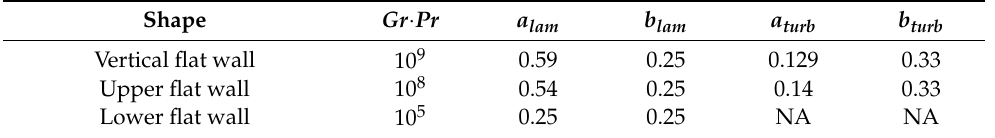
Table 1. Natural convection correlation coefficients; a lam is the value of coefficient a for laminar flow, b lam is the value of coefficient b for laminar flow, a turb is the value of coefficient a for turbulent flow, and b turb is the value of coefficient b for turbulent